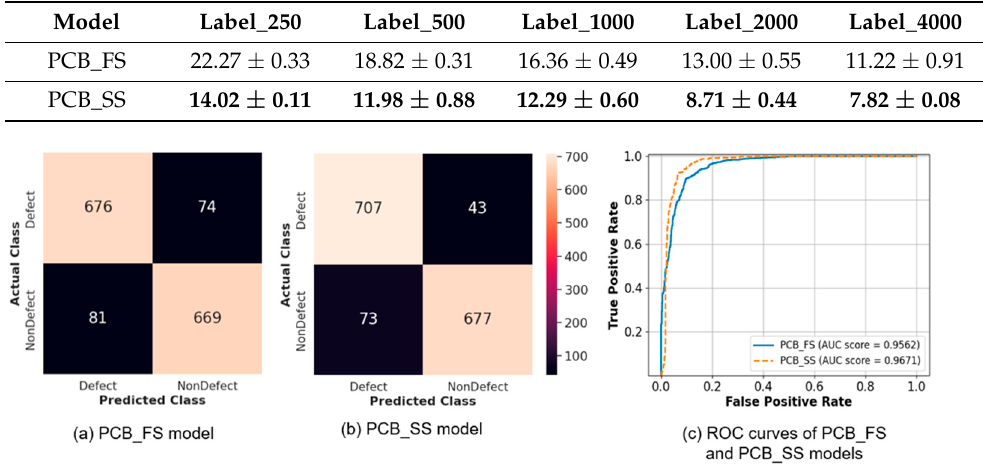
Figure 5. Learning curves during training for Label_250, Label_1000, and Label_4000: ( a – c ) total losses on training data (solid lines) and validation losses (dotted lines), ( d – f ) validation accuracies (circle and triangle: training steps of top three accuracies for PCB_FS and PCB_SS, respectively), and ( g – i ) unsupervised losses on the unlabeled data of the PCB_SS model. Table 5. Error rates (%) of test data with different numbers of labeled data (Best result in bold).